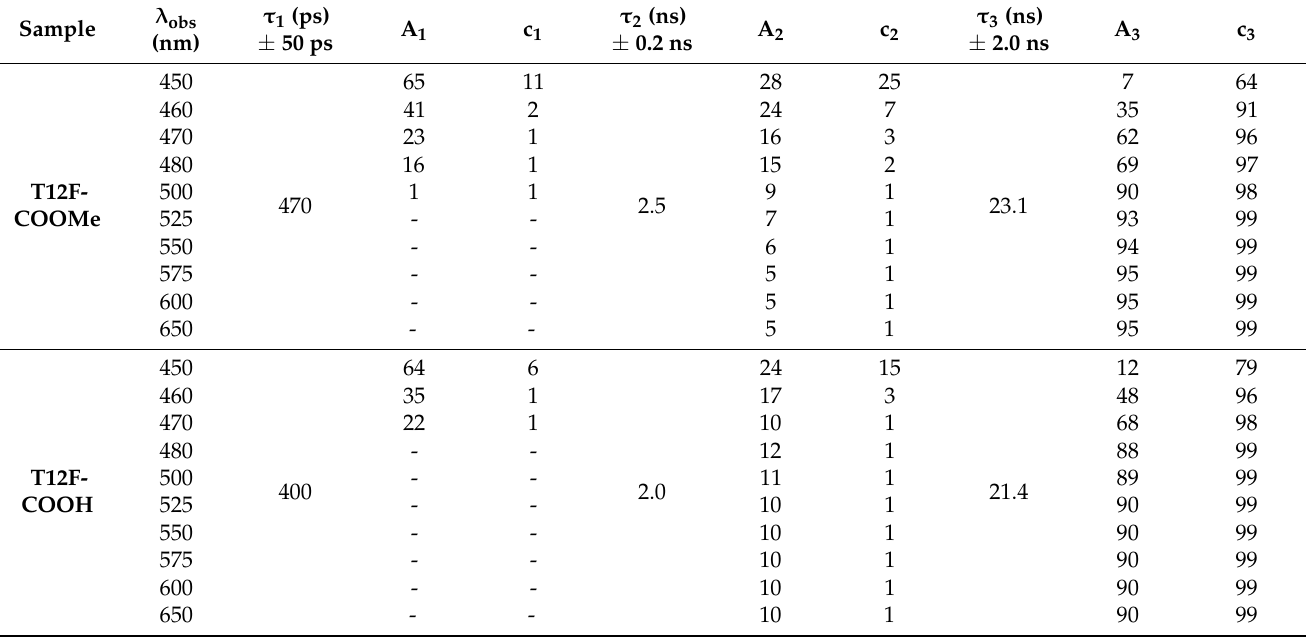
Table 2. Values of time constants ( τ i ), normalized (to 100) pre-exponential factors (a i ), and contributions (c i = τ i × a i / ∑ ( τ i × a i )) in the signal obtained from a global multiexponential fit for T12F-COOMe and T12F-COOH in DMF solution, and upon excitation at 390 nm. The observation wavelengths are